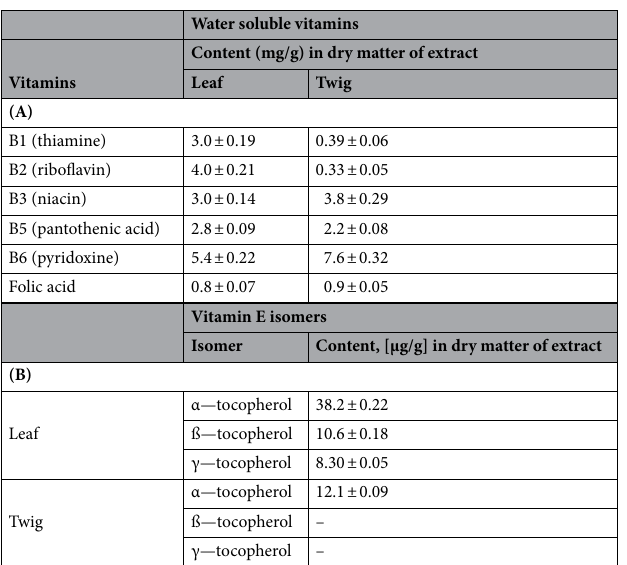
Table 3. Content of water-soluble vitamins (A) and tocopherol isomers (B) in dry matter of extracts of twigs and leaves from Hippophae rhamnoides L. Values are means ± SD (n =